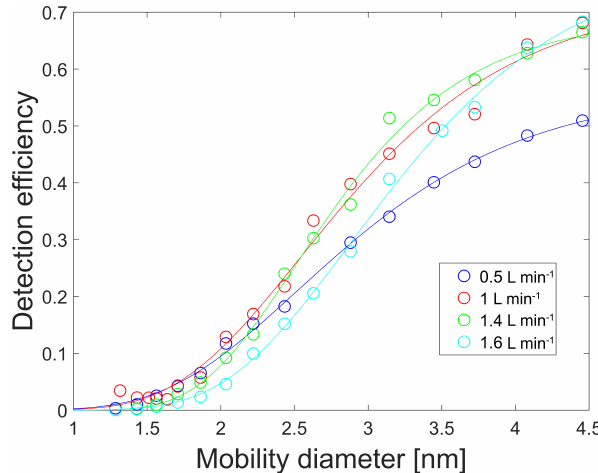
Figure 12. Detection efficiency of the 3777 as a function of the particle diameter and sample flow dew point.